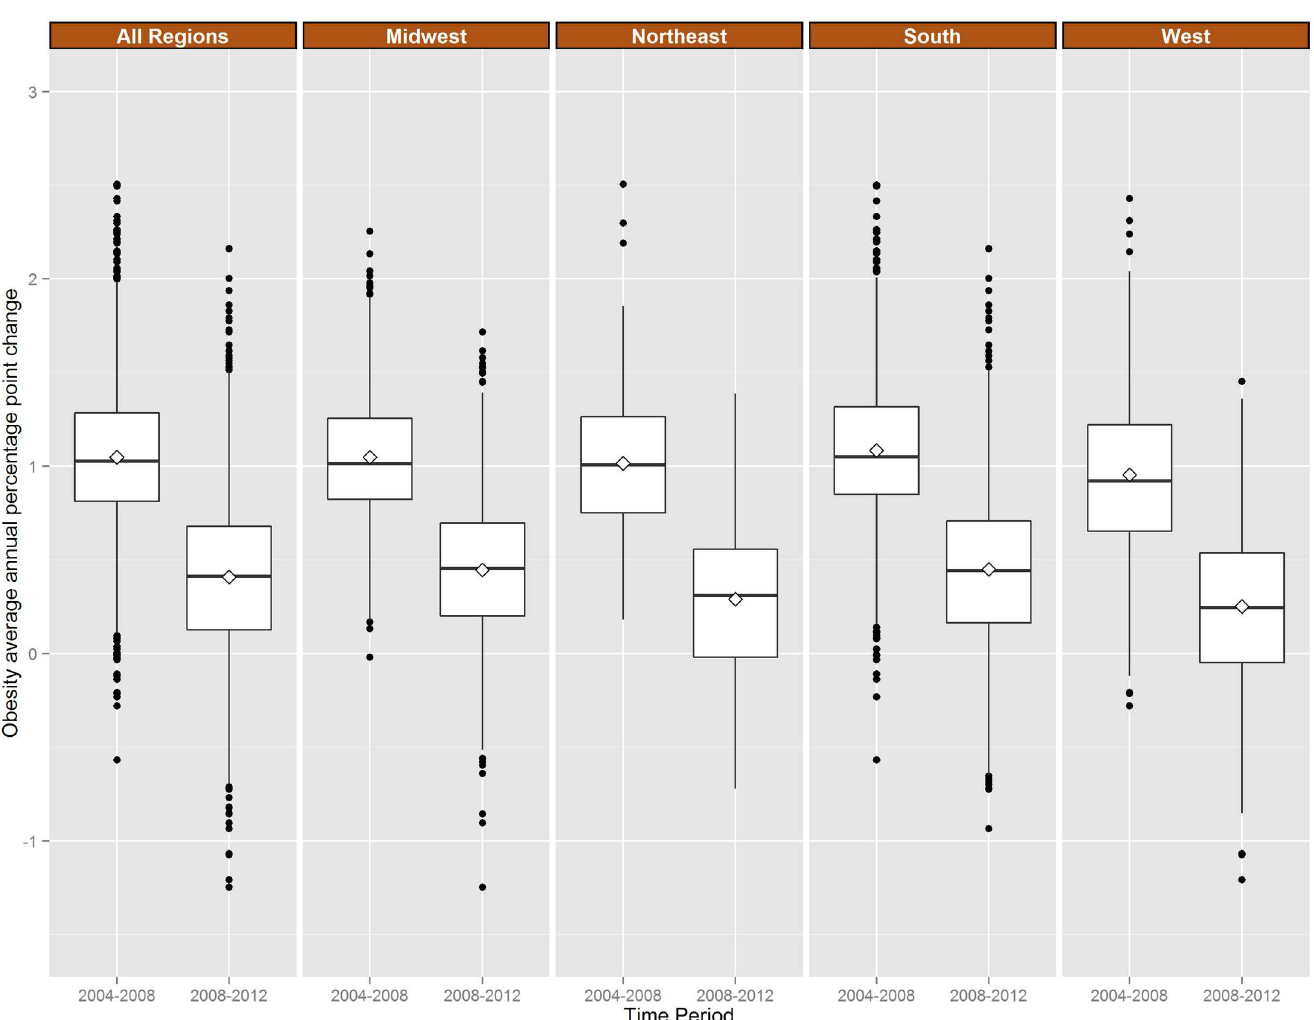
Fig 3. Distribution of county averageAnnual Percentage Point Change (APPC) in diagnosed obesity, by Census region, 2004–2008and 2008– 2012. Northeast regionincludesConnecticut, Maine, Massachusetts, New Hampshire,New Jersey, New York, RhodeIsland, Vermont, and Pennsylvania; Midwest regionincludesIllinois,Indiana, Iowa, Kansas, Michigan,Minnesota,Missouri, Nebraska, North Dakota, Ohio, South Dakota, and Wisconsin;South regionincludesAlabama, Arkansas, Delaware,District of Columbia,Florida, Georgia, Kentucky, Louisiana, Maryland,